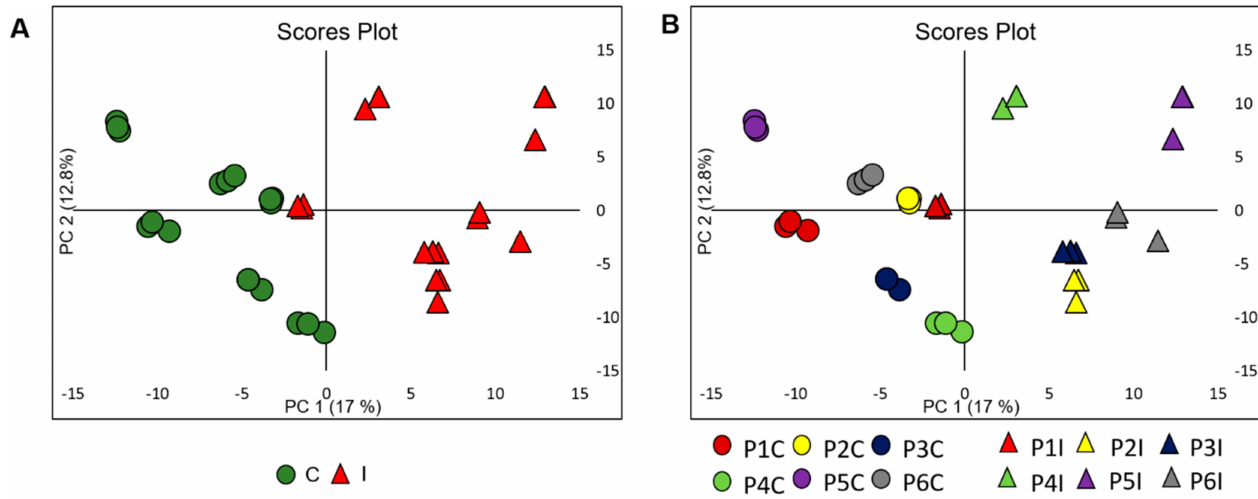
Figure 1. Unsupervised chemometric modeling (UHPLC-ESI-(+)-MS/MS data): ( A ) PCA scores of 18 samples (triplicate of 6 control plants and 6 inoculated plants), green circles correspond to control plant samples (C), red triangle corresponds to inoculated plant samples (I). ( B ) The scores plot in ( A ) but colored according to triplicate each plant (P). 5 PCs explained 51.6% of the total data variance.